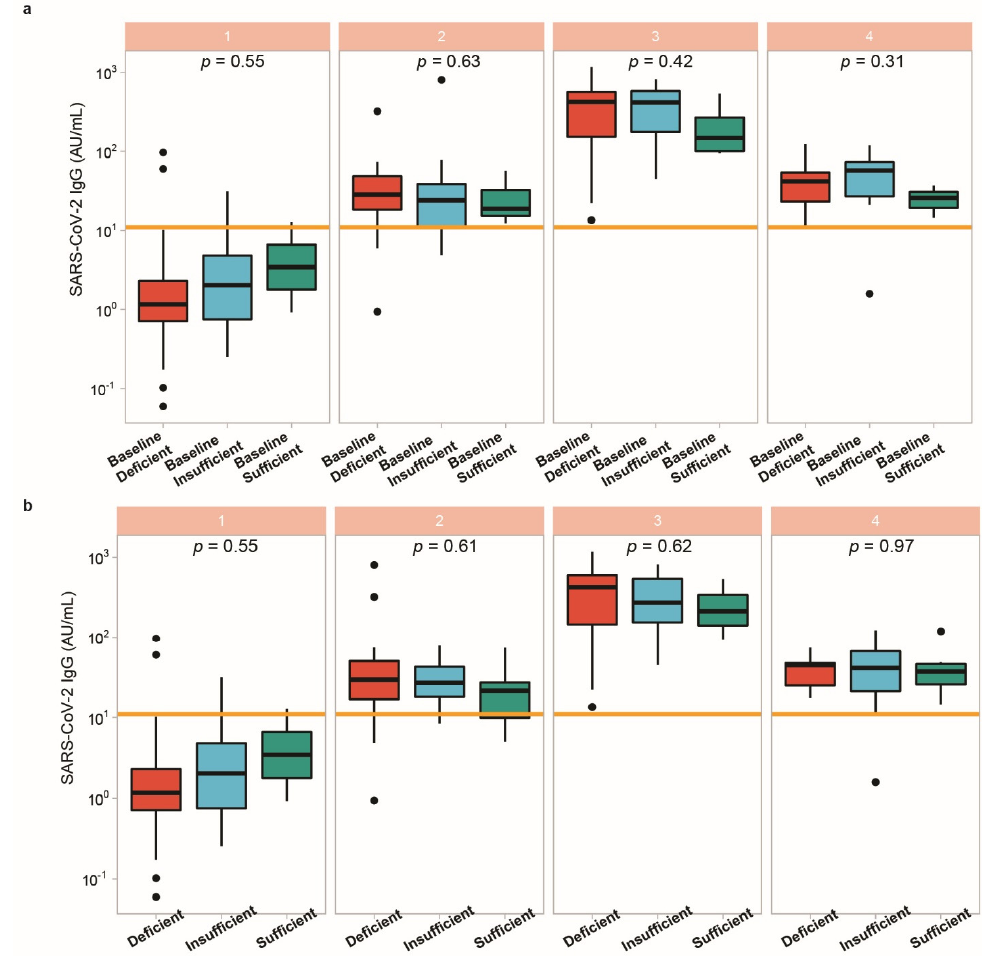
Figure A2. Vitamin D status in relation to SARS-CoV-2 IgG excluding patients using supplementary vitamin D. The analysis of SARS-CoV-2 IgG concentrations in relation to vitamin D status in the cohort of subjects not actively taking supplementary vitamin D intake does not reveal significant antibody differences according to ( a ), the vitamin D status at baseline, or ( b ), the actual vitamin D status at sampling time. Kruskal-Wallis test was used for comparing the groups.